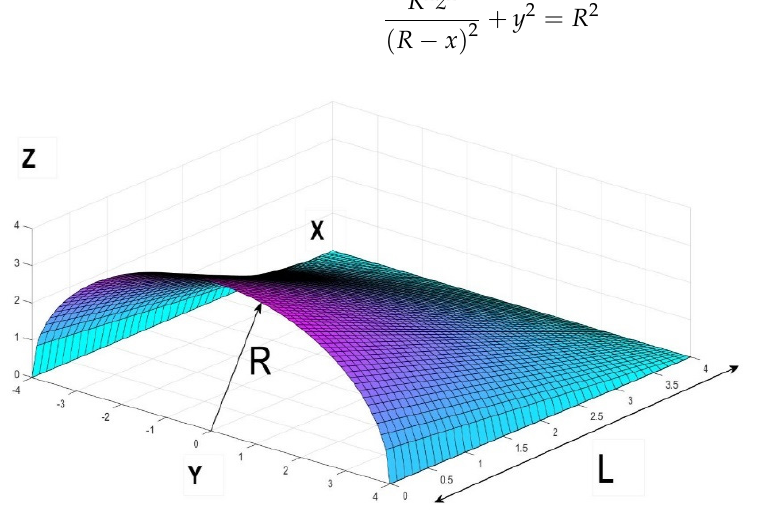
Figure 2. Explanation of the parts of a straight conoid with circular directrix, in this case R = L = 4.